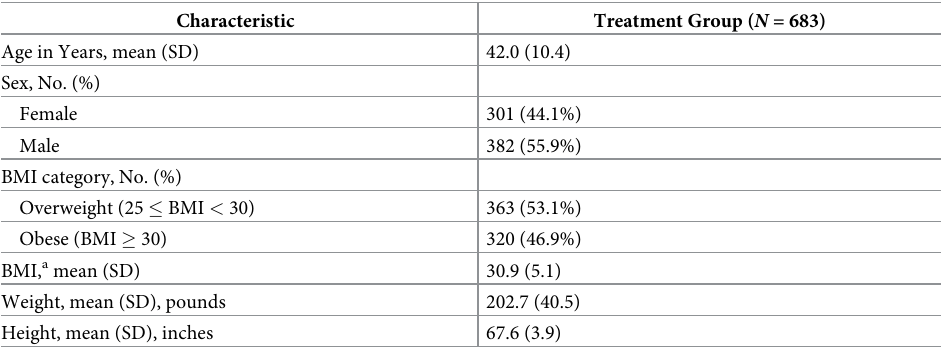
Table 1. Baseline